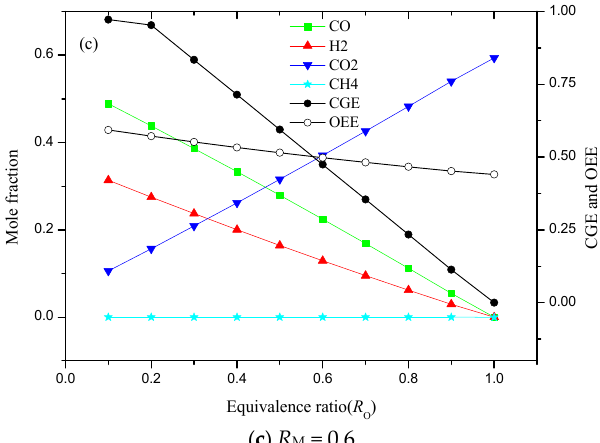
Figure 4. Effect of R o on raw syngas composition and system performance ( T = 900 °C and R c = 0.5): ( a